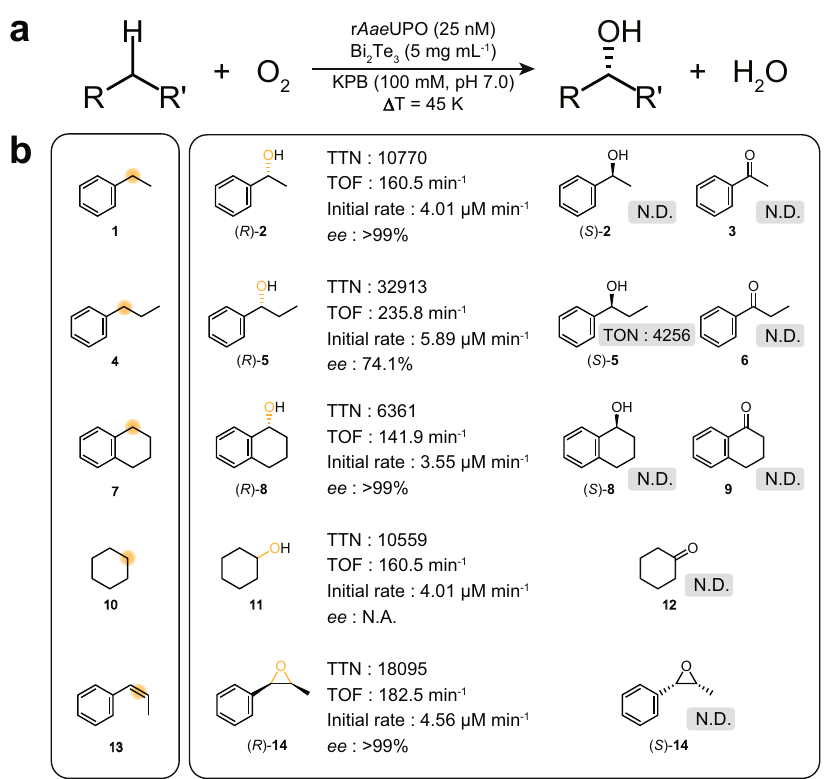
Fig. 4 Substrate scope of thermoelectrobiocatalytic oxyfunctionalization reactions by Bi 2 Te 3 /r Aae UPO. a A brief reaction equation of the thermoelectrobiocatalytic oxyfunctionalization of hydrocarbons by the Bi 2 Te 3 /UPO couple. b Selective hydroxylation reactions of ethylbezene ( 1 ), propylbenzene ( 4 ), cyclohexane ( 7 ), and tetralin ( 10 ), and selective styrene epoxidation reaction of cis - β -methylstyrene ( 13 ). Note that all quantities were determined from gas chromatographic analyses. Initial rate and TOF were determined at 15 min of reaction (30 min for hydroxylation of cyclohexane). TTN and ee were determined by the maximum value of reactions. Reaction conditions: 5 mg mL − 1 Bi 2 Te 3 , 25 nM r Aae UPO, and 100 mM ethylbenzene dispersed in an O 2 -purged KPB (100 mM, pH 7.0) with applied Δ T (45 K). For styrene epoxidation of compound 13 , we applied 35 K of Δ T to avoid the ignition of compound 13 . Reaction time = 48 h. N.D. not detected, N.A. not